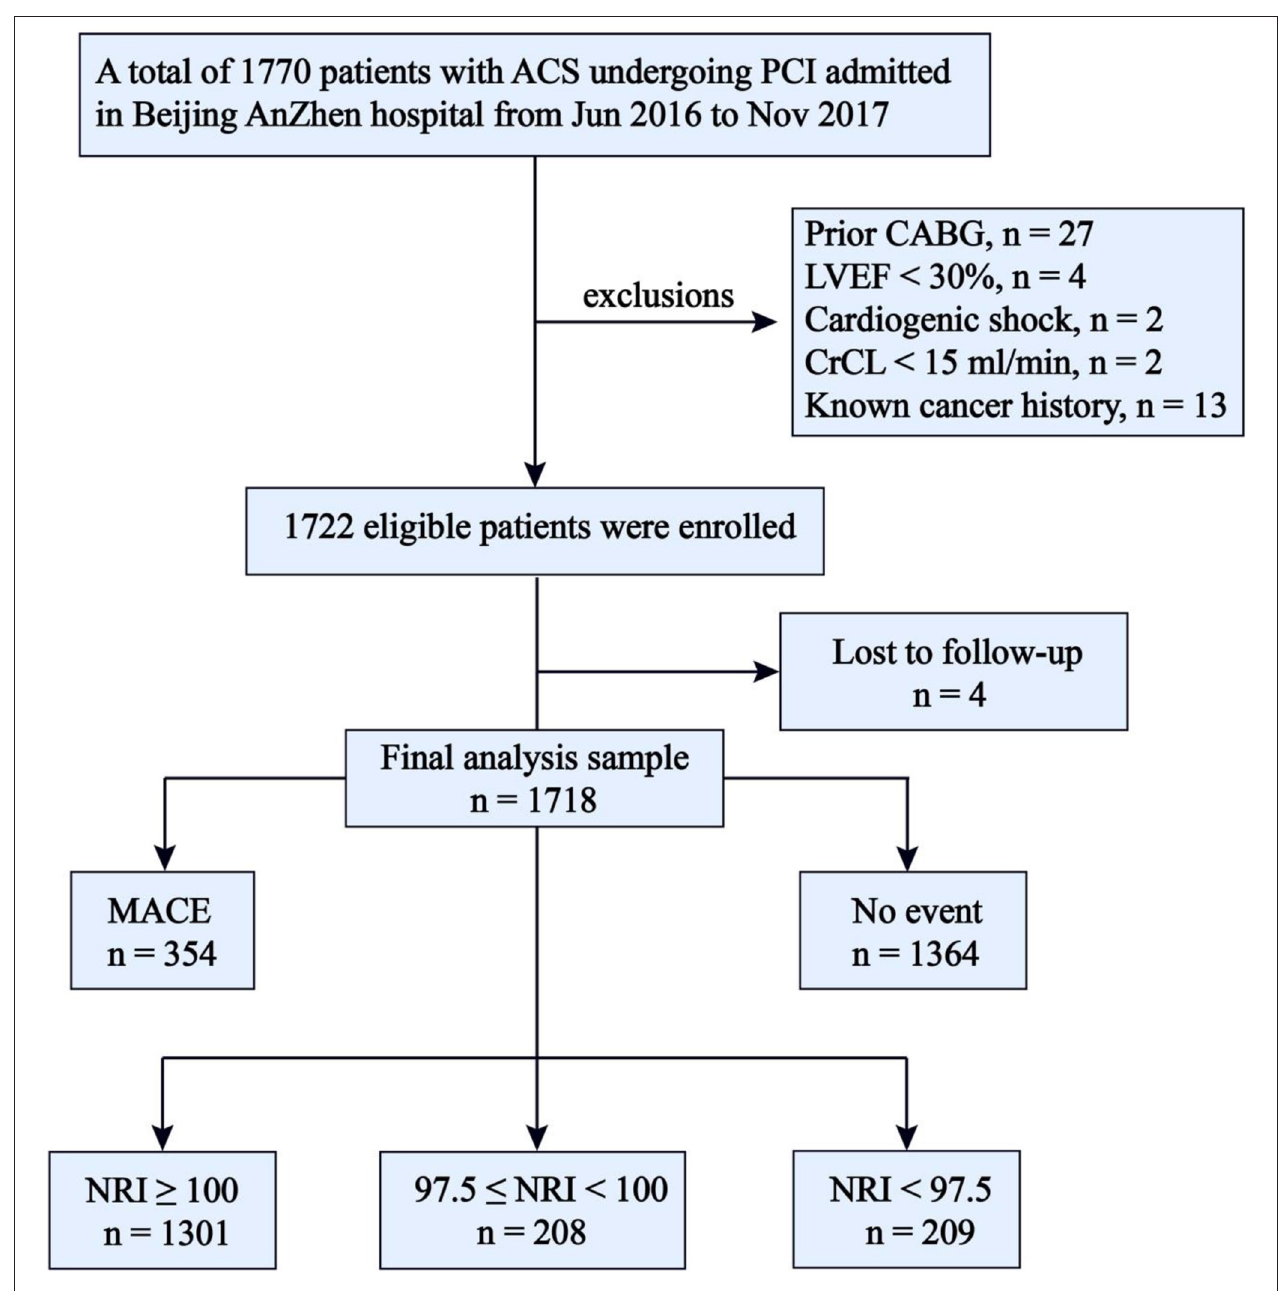
FIGURE 1 | Flow chart. ACS, acute coronary syndrome; PCI, percutaneous coronary intervention; CABG, coronary artery bypass graft surgery; LVEF, left ventricular ejection fraction < 30%, CrCL, creatinine clearance < 15 ml/min; NRI, nutritional risk index; MACE, major adverse cardiovascular events; NRI, nutritional risk index.